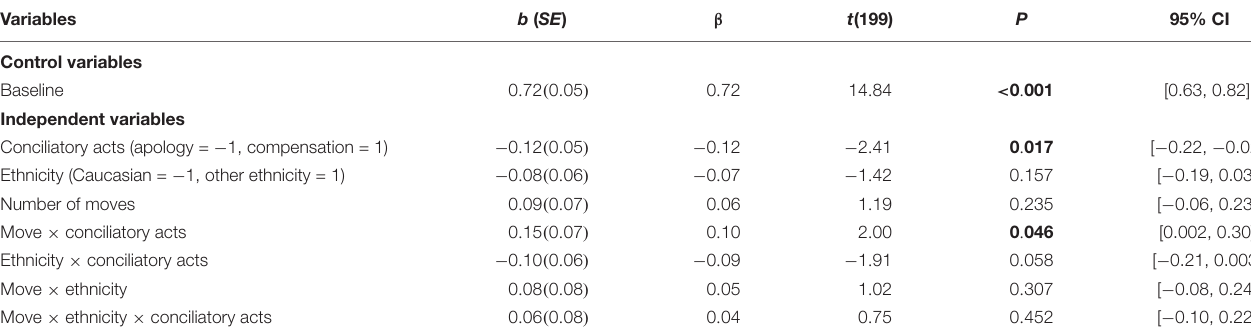
TABLE 2 | The results of regression analysis (Study 2b).